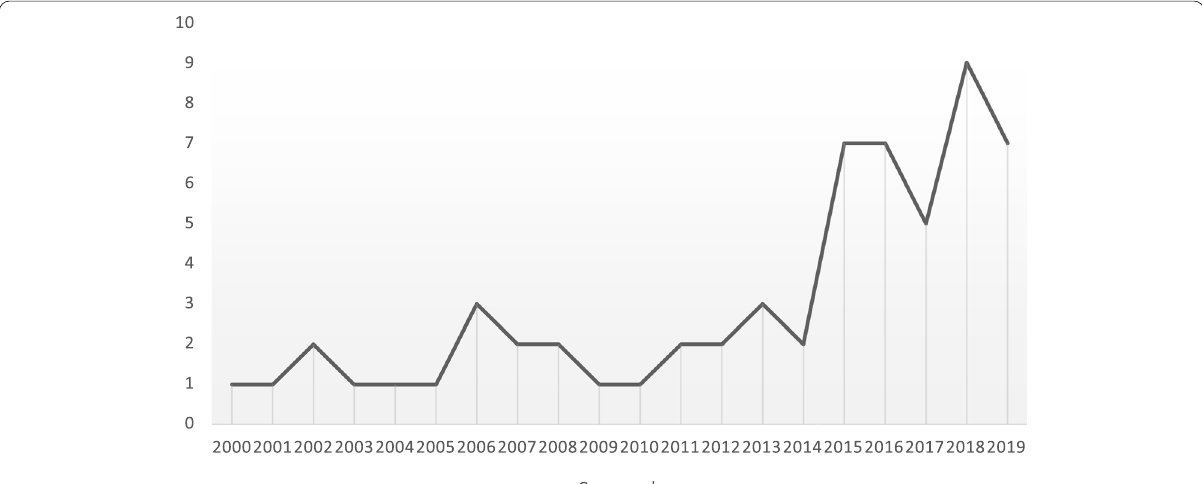
Fig. 1 Healthcare professionals murders between 2000 and 2019 in Turkey. This situation follows a relatively stable (ranging from 1 to 3 cases/year) course between 2000 and 2014. The dramatic increase in healthcare worker murders after 2015 draws